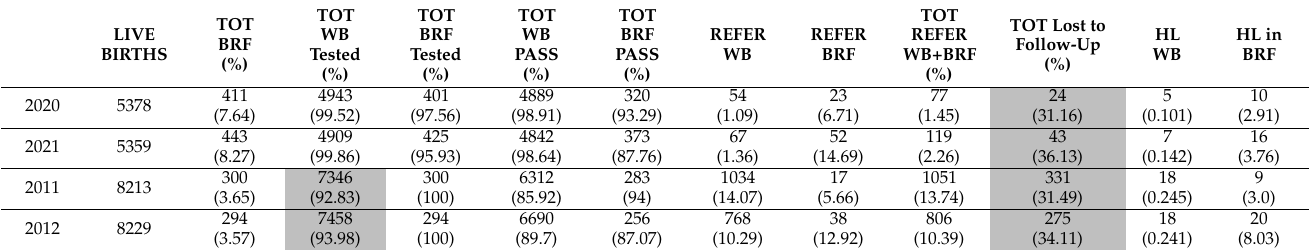
Table 1. UNHS activities conducted in the Umbria region in 2020–2021.